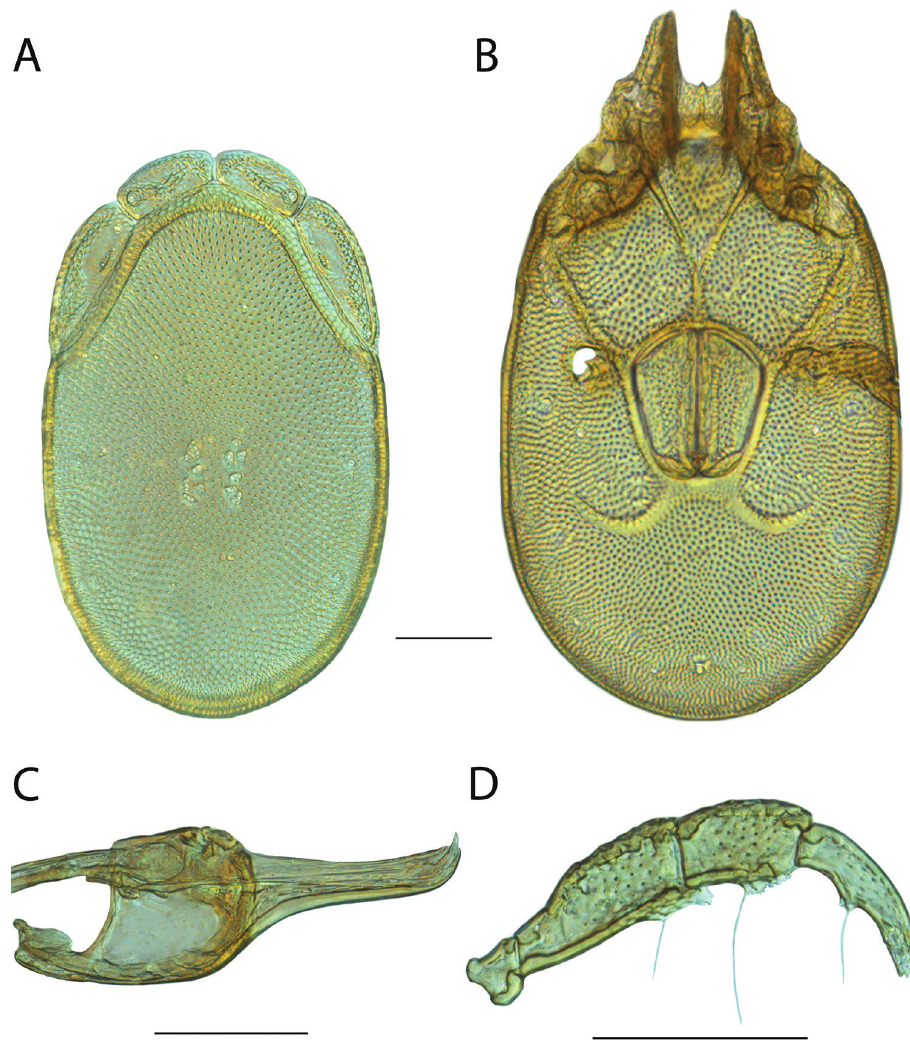
Figure 191. Torrenticola pinocchio sp. n. female: A dorsal plates B venter (legs removed) C subcapitulum D pedipalp (setae not accurately depicted). Scale = 100